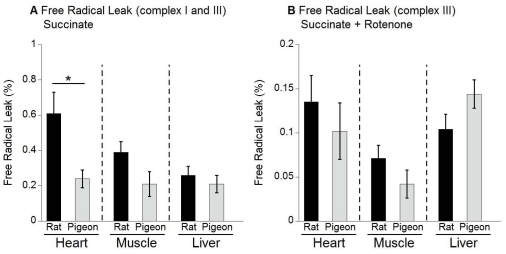
The mitochondrial free radical leak (FRL).The FRL was determined in the absence (A) and presence of rotenone (2 µM; B) in succinate-energized mitochondria of rat (black bars) and pigeon (grey bars) heart, pectoral muscle and liver mitochondria. The FRL is the percentage of electrons leaking out of sequence towards the production of superoxide. Rotenone inhibits complex I of the respiration chain; the FRL shown in (B) results mainly from electrons leaking at complex III. For FRL calculations see method section. Shown are means ± SEM, n = 7 for rats and n = 8 for pigeons. Significant differences are highlighted with an asterisk (p<0.05).